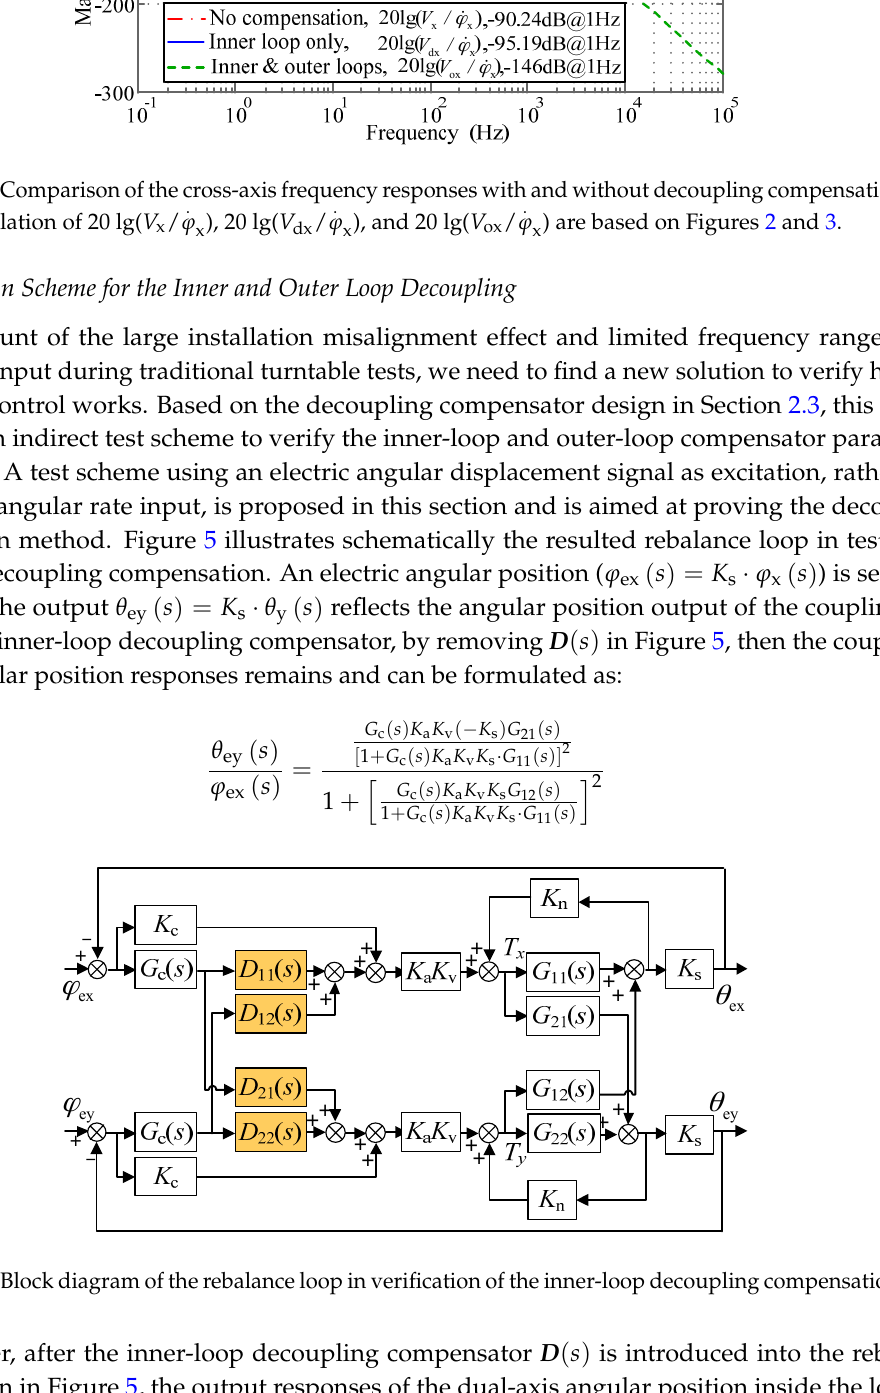
. . . ϕ ϕ ϕ ), 20 lg( V dx / ), and 20 lg( V ox / ) are based on Figures 2 and 3. V /   ), 20 lg( V /   ), and 20 lg( V /   ) are based on x x x x x dx x ox x